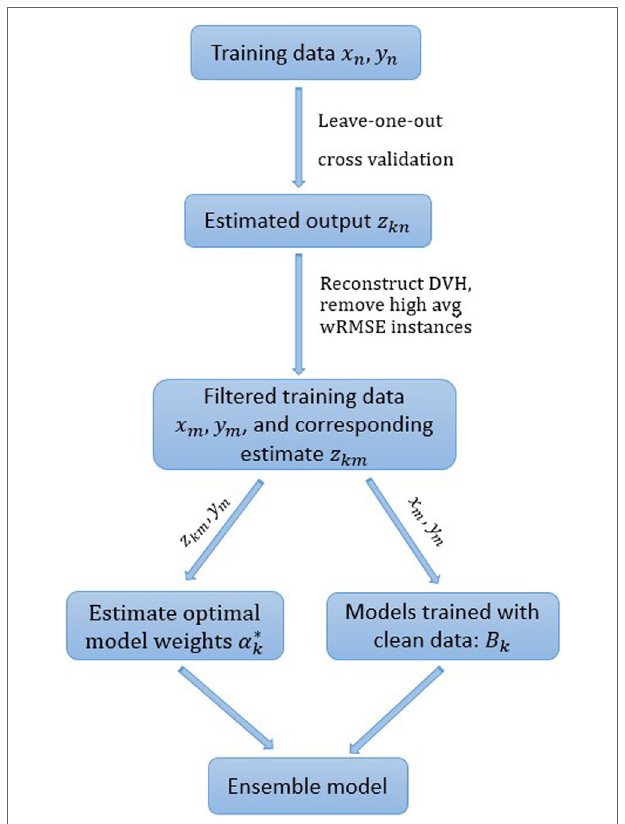
FigUre 3 | The proposed ensemble learning